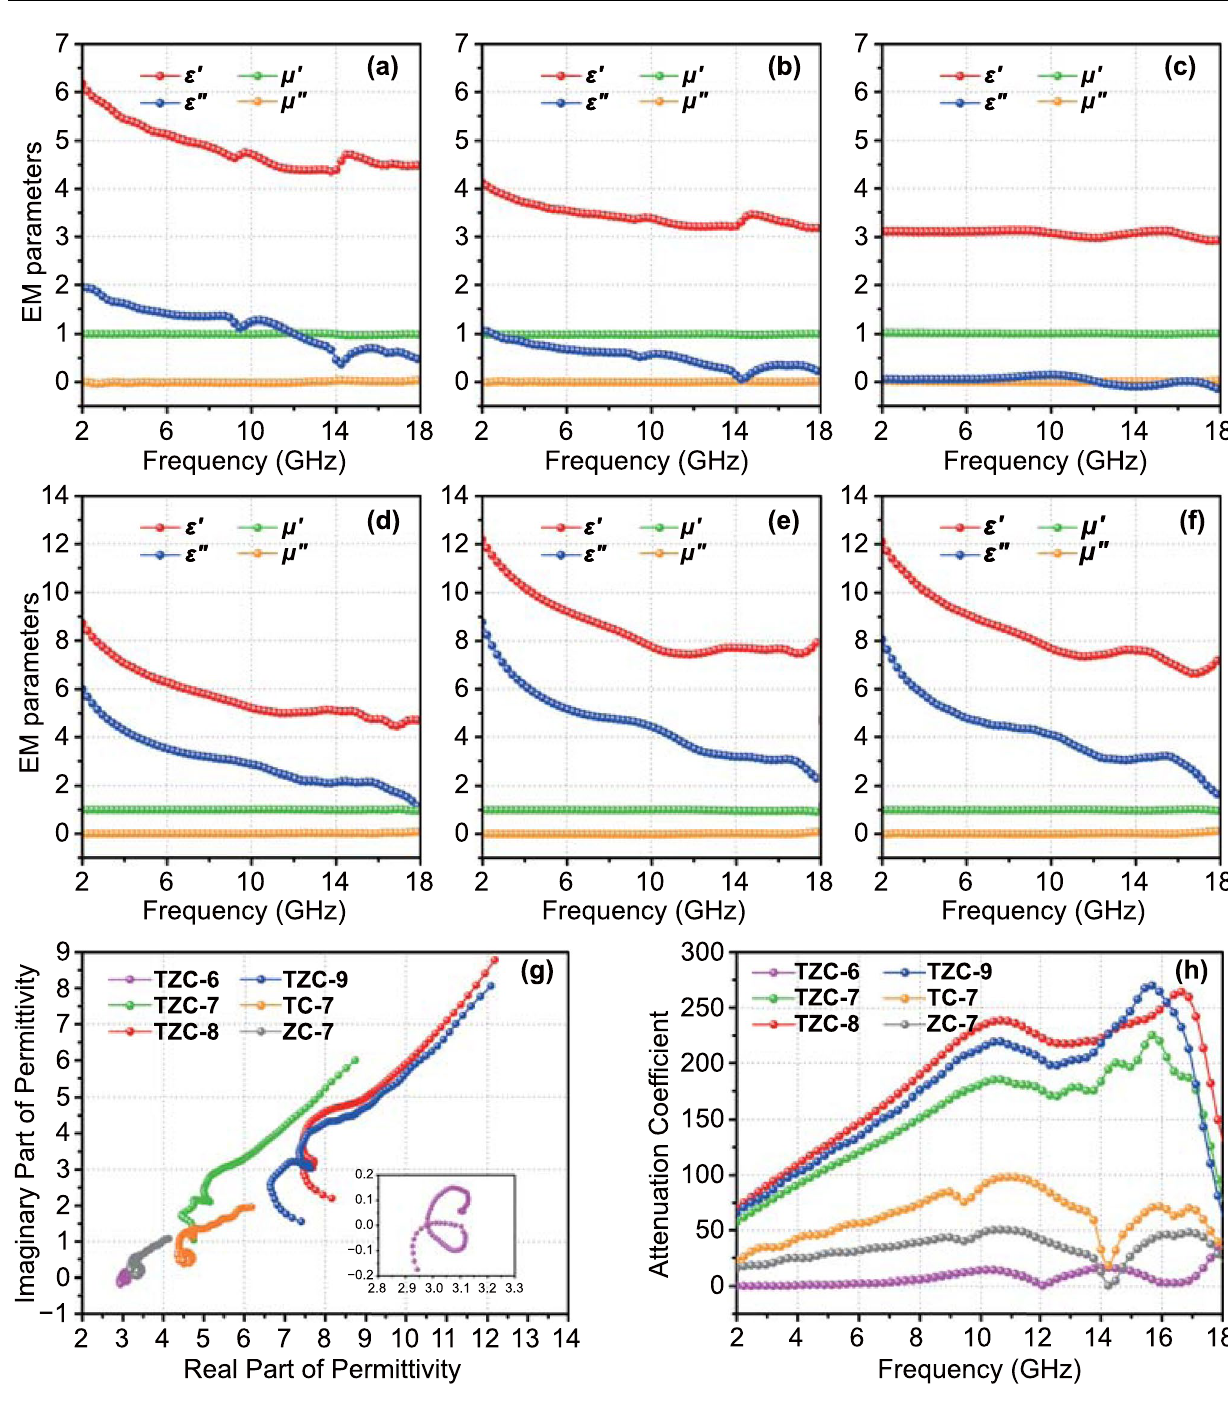
Fig. 6 Electromagnetic parameters of a TC-7, b ZC-7, c TZC-6, d TZC-7, e TZC-8, and f TZC-9. g Cole–Cole plots, and h attenuation coef- ficient of all MOF